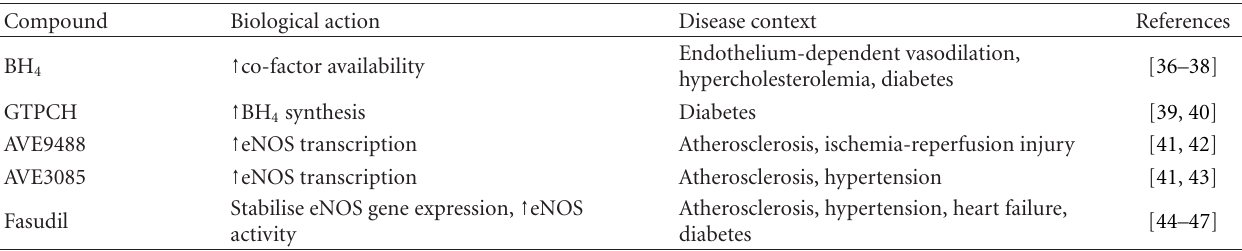
Table 1: Novel targets that regulate eNOS